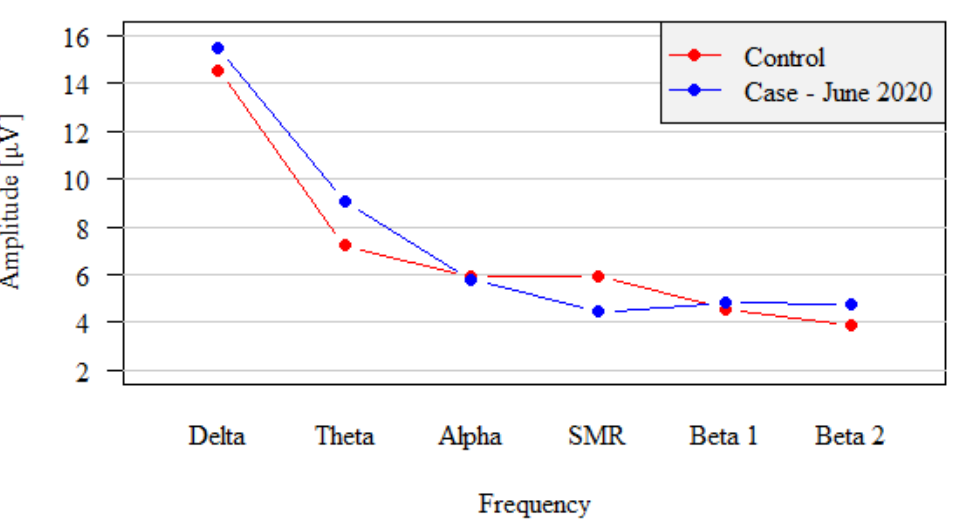
Figure 3. Comparison between left hemispheric (C3) QEEG recordings in test patient with panic attacks after completing the neurofeedback training (blue dots and lines) vs. non-affected subject (control, red dots and lines).